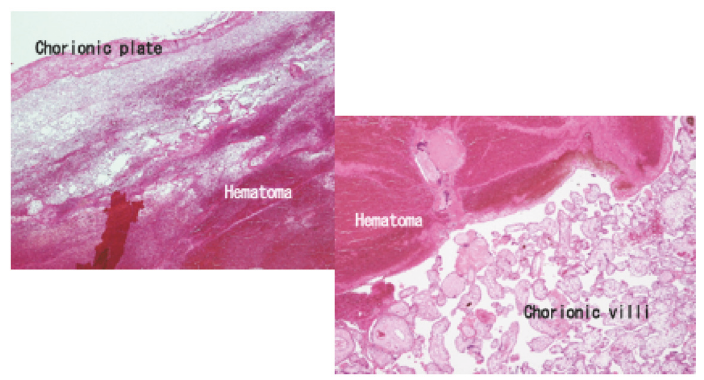
Figure 3: Microscopic examination revealed an intervillous hematoma and fibrinous deposits directly beneath the chorionic plate with adjacent compressive effects (hematoxylin-eosin staining, 20 ×